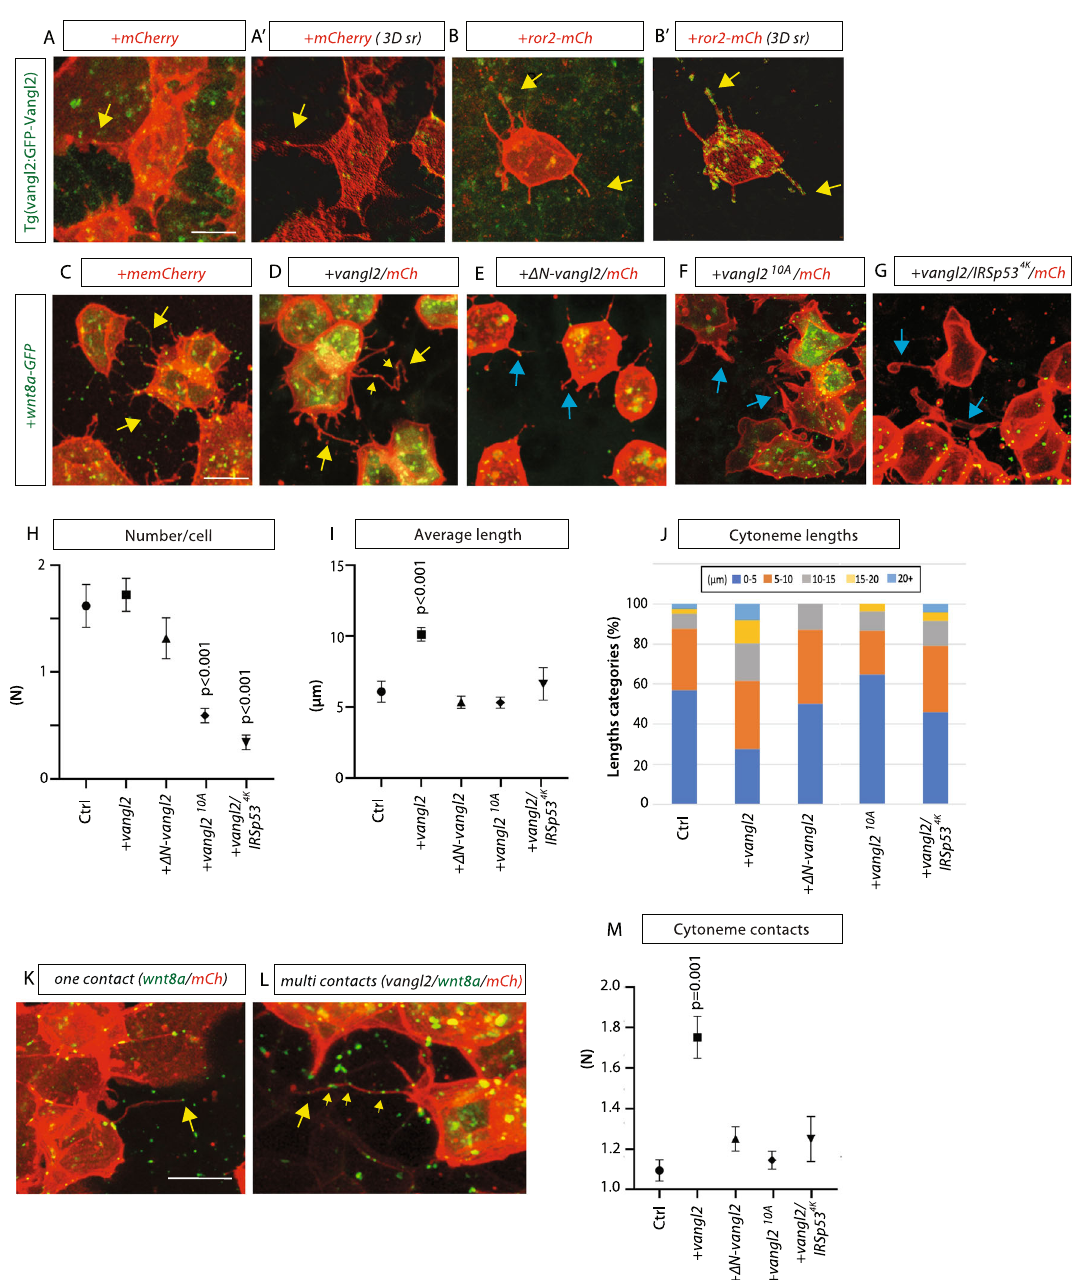
Fig. 3 Vangl2 regulates length and contacts of Wnt8a cytonemes in the zebra fi sh embryo. A , B ’ Tg(vangl2:GFP-Vangl2) zebra fi sh embryos were injected with mem-mCherry (mCh) or Ror2-Mcherry. A ’ , B ’ 3D renders (3D sr) of A&B at 5hpf. Yellow arrows show examples of Vangl2 positive